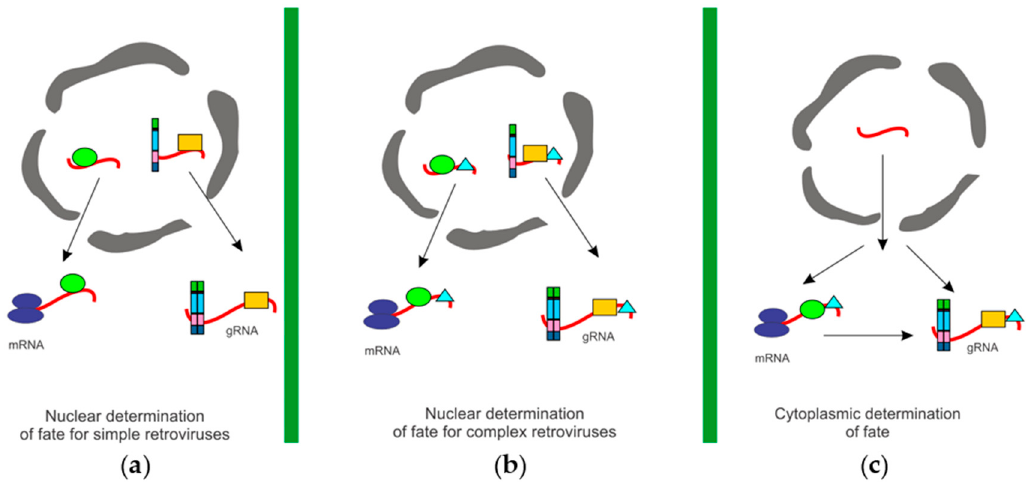
Figure 2. Models for unspliced retroviral RNA utilization. ( a ) Nuclear determination of vRNA fate for simple retroviruses: The cytoplasmic utilization of unspliced vRNAs may be determined by the co-transcriptional binding of specific factors that “mark” the unspliced vRNA for either packaging or translation, and the vRNAs are not interchangeable. The mechanism by which the unspliced RNA is exported from the nucleus could determine the cytoplasmic utilization of the unspliced retroviral RNA. Models include: (i) Nuclear Gag binds to the vRNA to mark it for packaging; (ii) Nuclear Gag and a host factor bind to the vRNA to mark it for packaging; or (iii) Nuclear host factors bind to the unspliced vRNA to determine its fate; ( b ) Nuclear determination of fate for complex retroviruses: Complex retroviruses encode accessory proteins that facilitate the nuclear export of unspliced or incompletely spliced retroviral RNA, such as HIV-1 Rev. In addition to Rev-like proteins, other host and viral factors also bind to the unspliced vRNA co-transcriptionally and may contribute to the fate of unspliced vRNA. Models include: (i) Nuclear viral export factor and Gag bind to the vRNA to mark it as a genome for packaging; (ii) Nuclear viral export factor, Gag, and a host factor bind to the vRNA to sort it for packaging; or (iii) Nuclear viral export factor and specific host factors bind to the unspliced vRNA to determine its cytoplasmic fate; ( c ) Cytoplasmic determination of fate: The fate of unspliced vRNAs may be defined in the cytoplasm. An unspliced vRNA can be used for either translation or packaging. A previously translated RNA can subsequently be packaged. In this scenario, host and viral factors may be bound to the unspliced vRNA in the nucleus, but their presence does not determine cytoplasmic utilization of the vRNA.